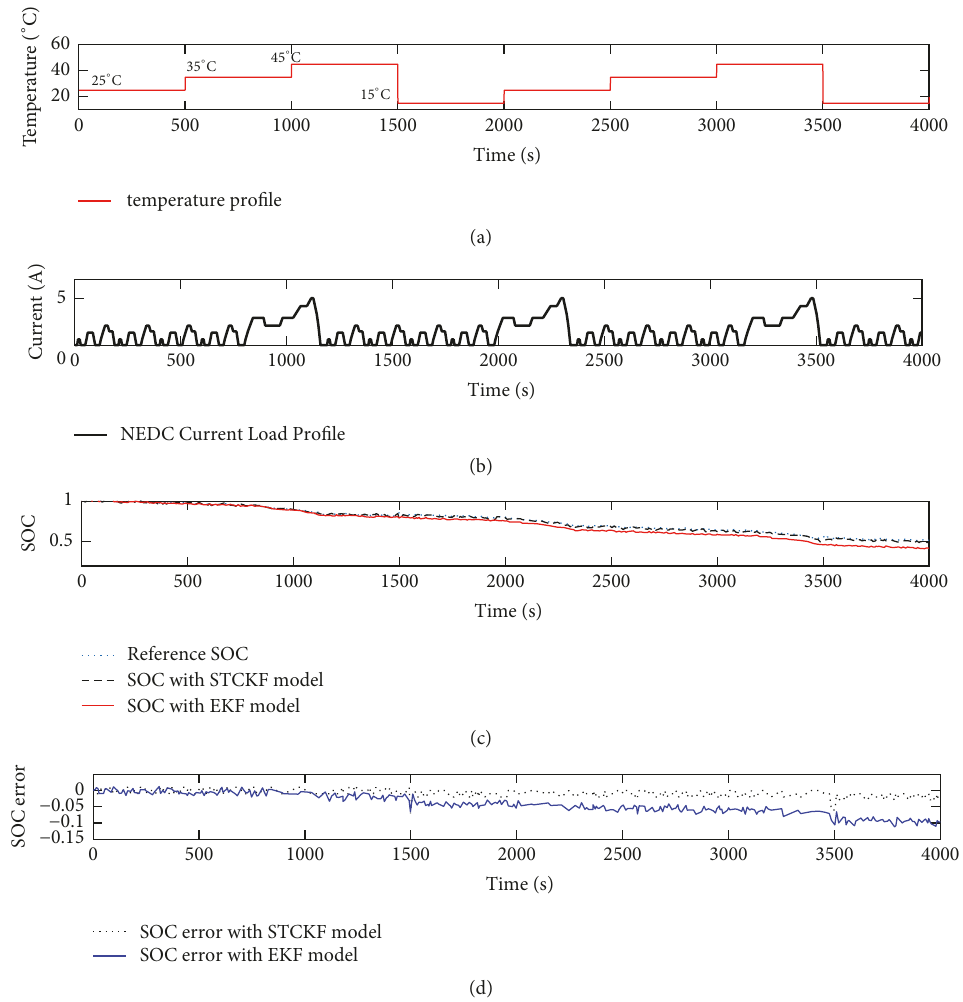
Figure 13: (a) Ambient temperature profile; (b) current profile; (c) SOC comparison of proposed STCKF and EKF-based model; (d) SOC error